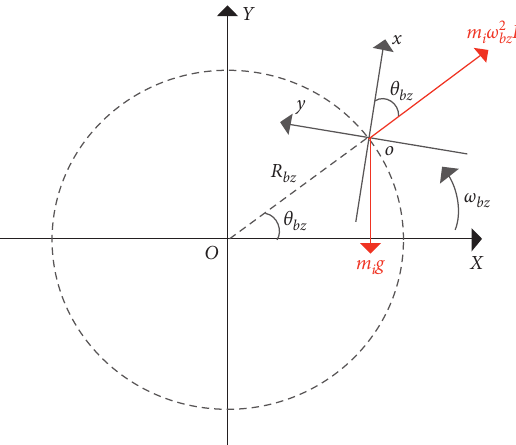
Figure 5: Force analysis of the rotor system during the barrel roll flight of an